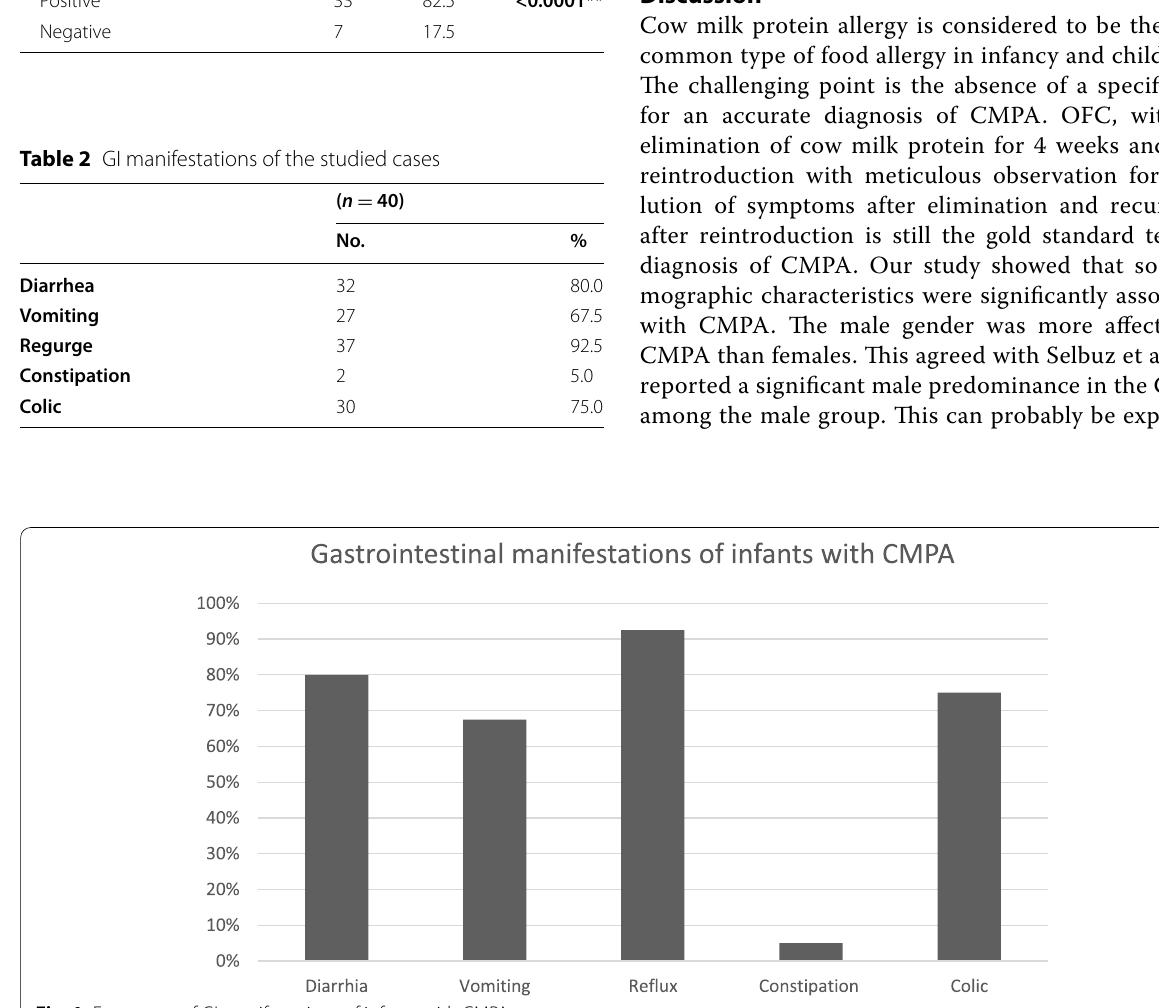
Fig. 1 Frequency of GI manifestations of infants with